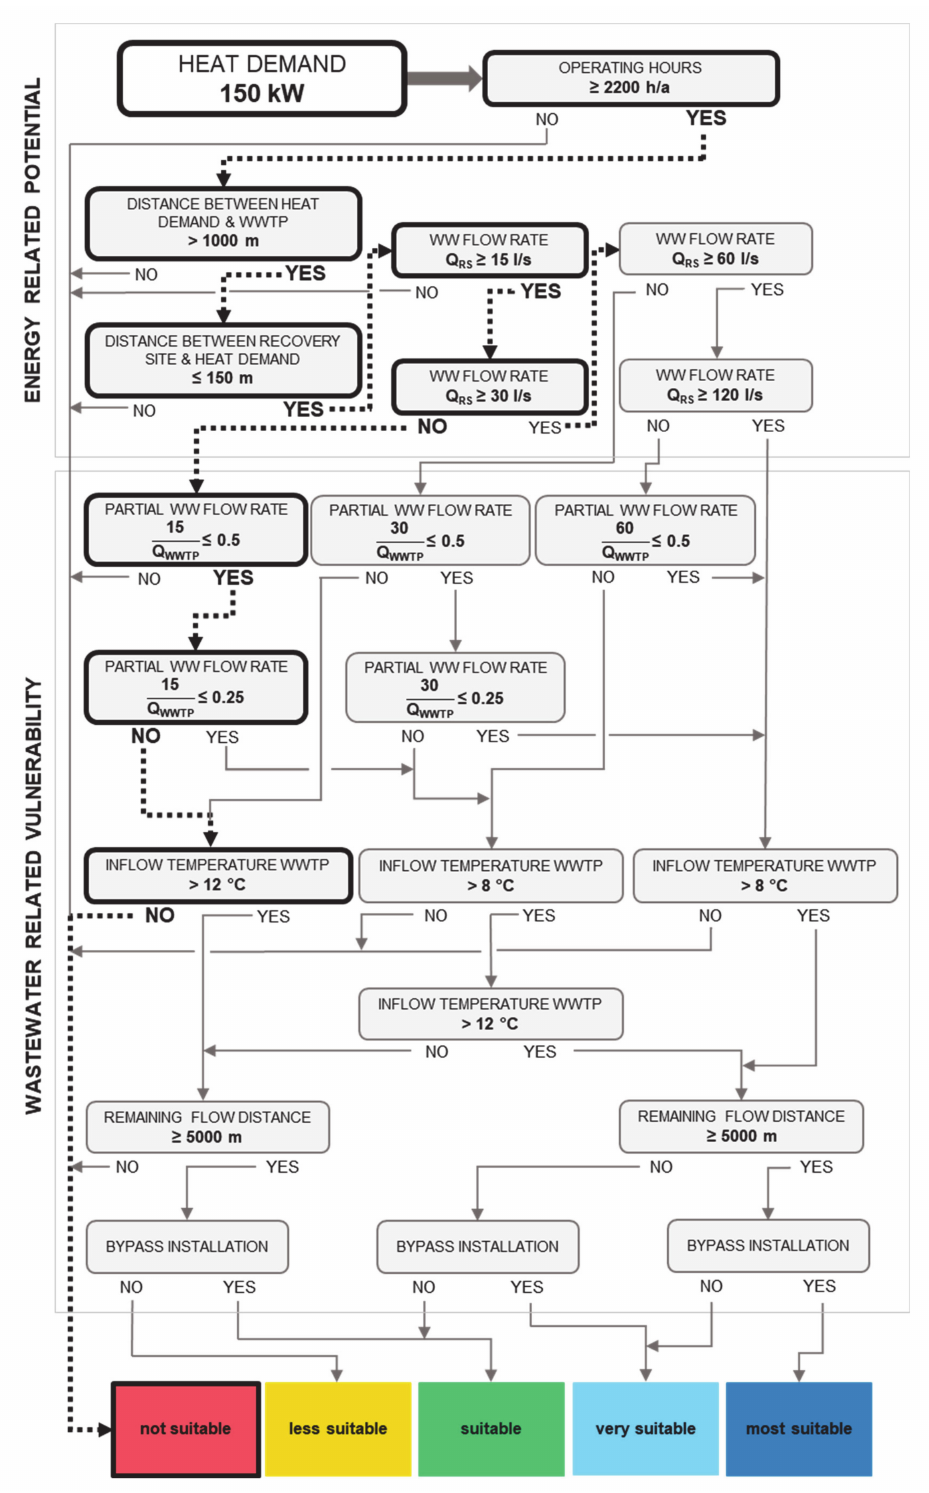
Figure 8. Pre-assessment process for heat recovery site M2 for an intended heat supply of 150 kW (own representation, based on